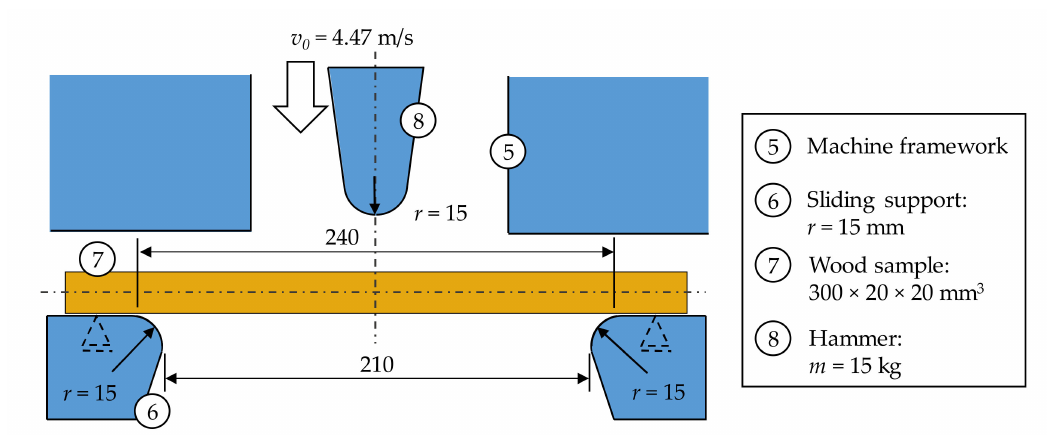
Figure 2. Boundary conditions and geometric dimensions of the wood sample within the impact pendulum testing